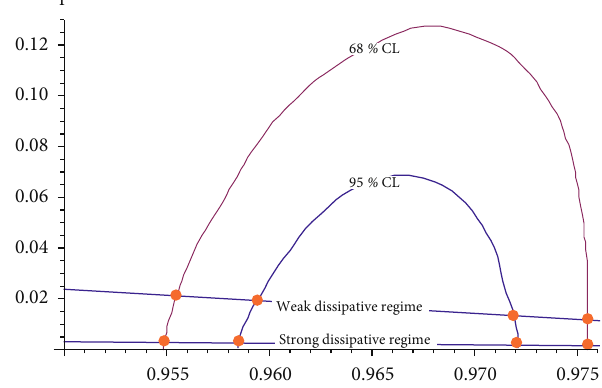
ρ = 10 − 14 , 0 : 1 < α < 1 . s .